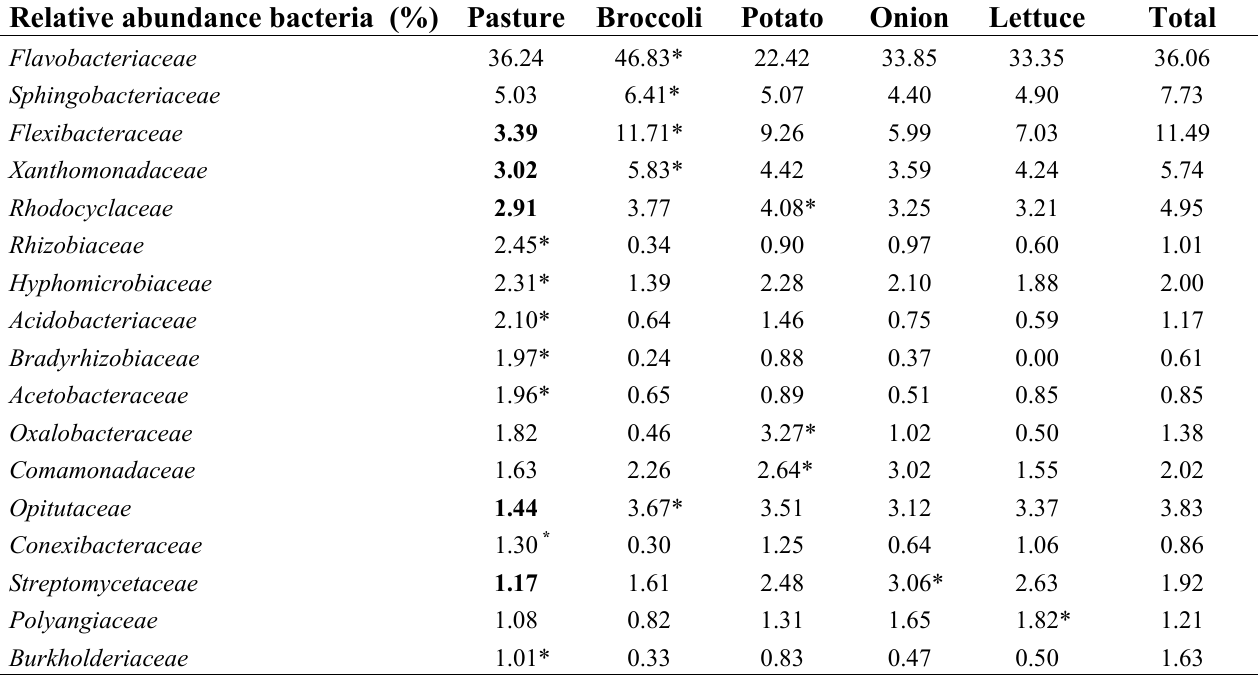
Table 3. Top predominant bacterial families under different rhizospheres in an organic production system (0–10 cm).